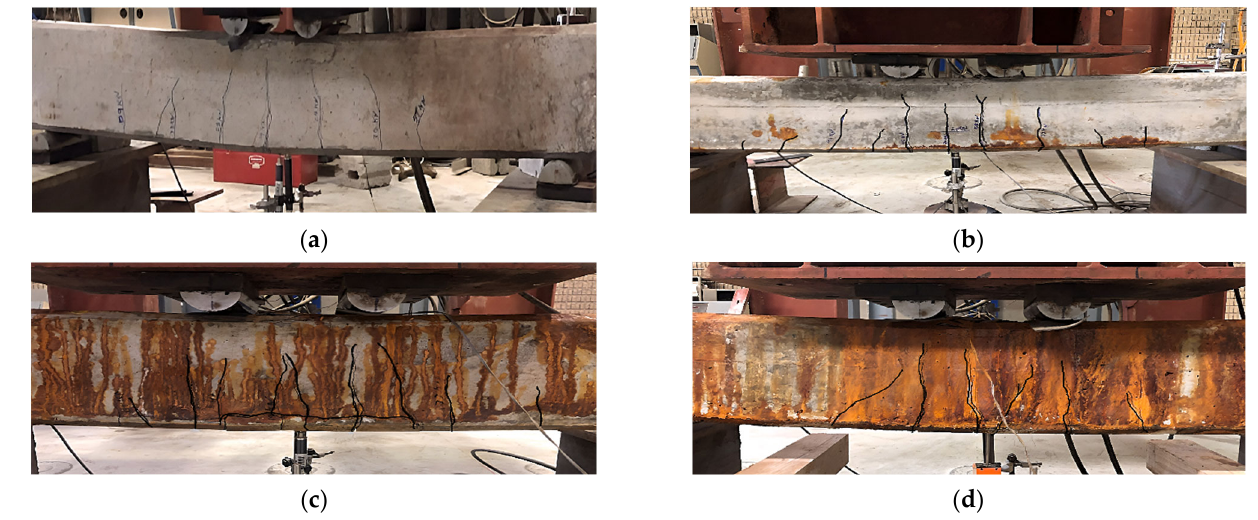
Figure 12. Failure modes of control and corroded RC beam specimens ( a ) control beam ; ( b ) beam A ; ( c ) beam B ; ( d ) beam C .